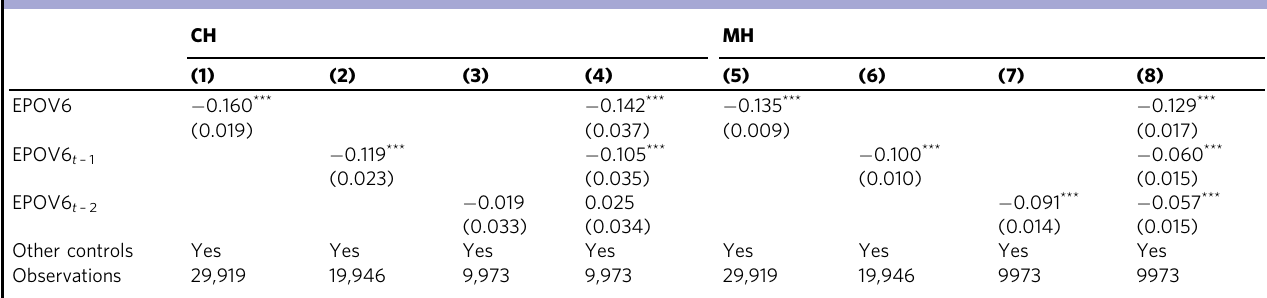
Table 8 Further investigation (effect of lagged EPOV on CMH).